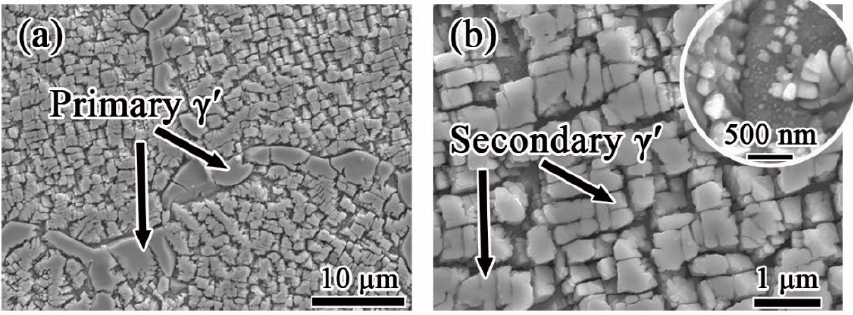
Figure 4. γ′ morphologies of FGH4107 after hot isostatic pressing : ( a ) primary γ′; ( b ) secondary γ′ . Figure 4. γ (cid:48) morphologies of FGH4107 after hot isostatic pressing: ( a ) primary γ (cid:48) ; ( b ) secondary γ (cid:48)